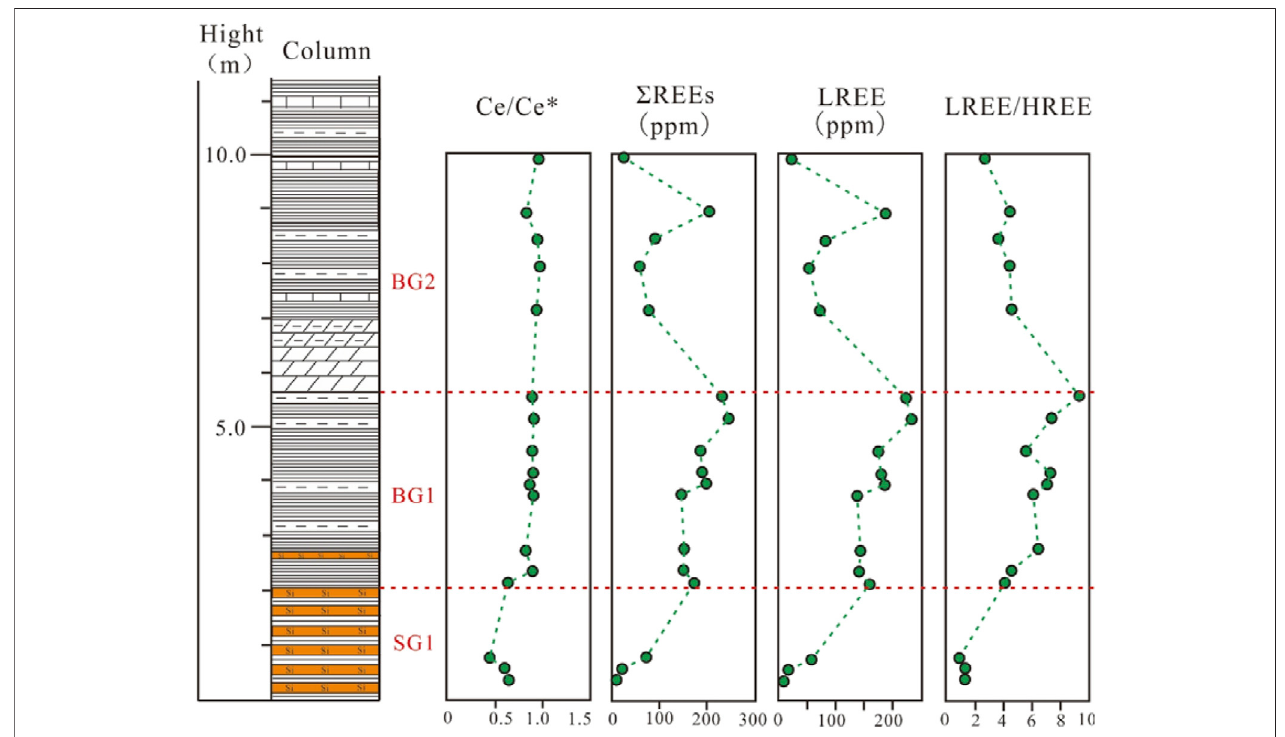
FIGURE 6 | Variations of Ce/Ce*, Σ REEs, LREE, and LREE/HREE with depth.